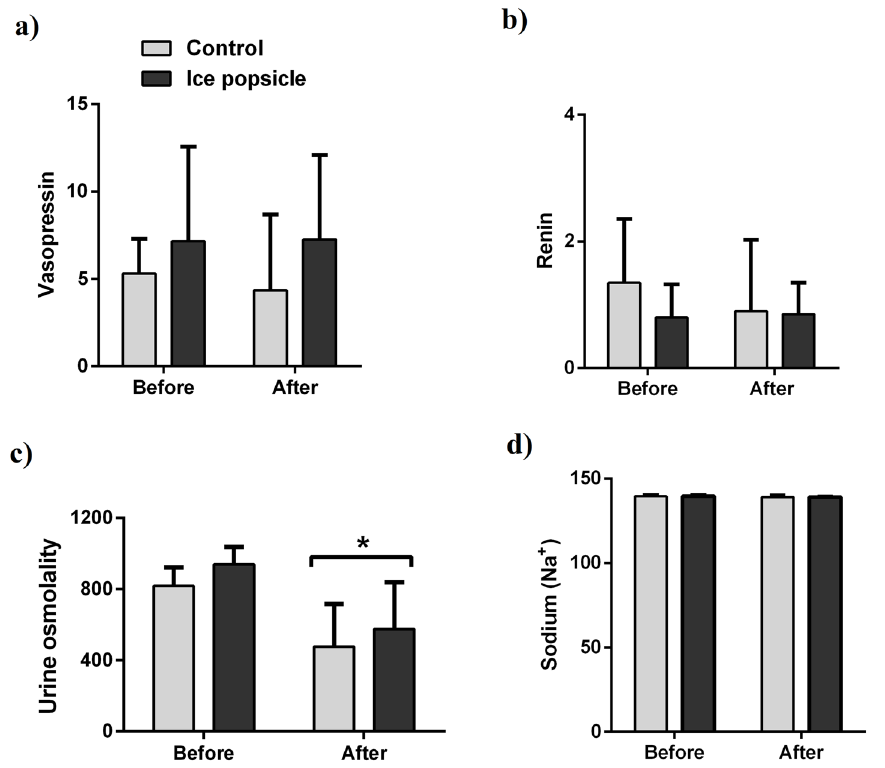
Figure 6. The effects of thirst management